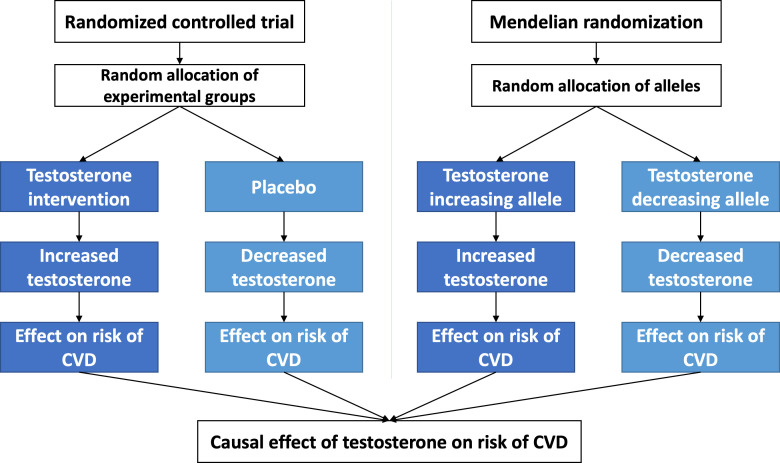
Comparison of randomized controlled trial (RCT) and Mendelian randomization (MR) study designs demonstrating the common foundation behind interpretation of a causal effect of testosterone on cardiovascular disease (CVD).In accordance with Mendel’s second law, random and independent inheritance of alleles can be thought of akin to random allocation of treatment vs. placebo in RCT. Therefore, by the same reasoning, if MR finds genetic variants affecting testosterone are associated with a difference in CVD risk, it provides evidence that testosterone causally affects CVD.